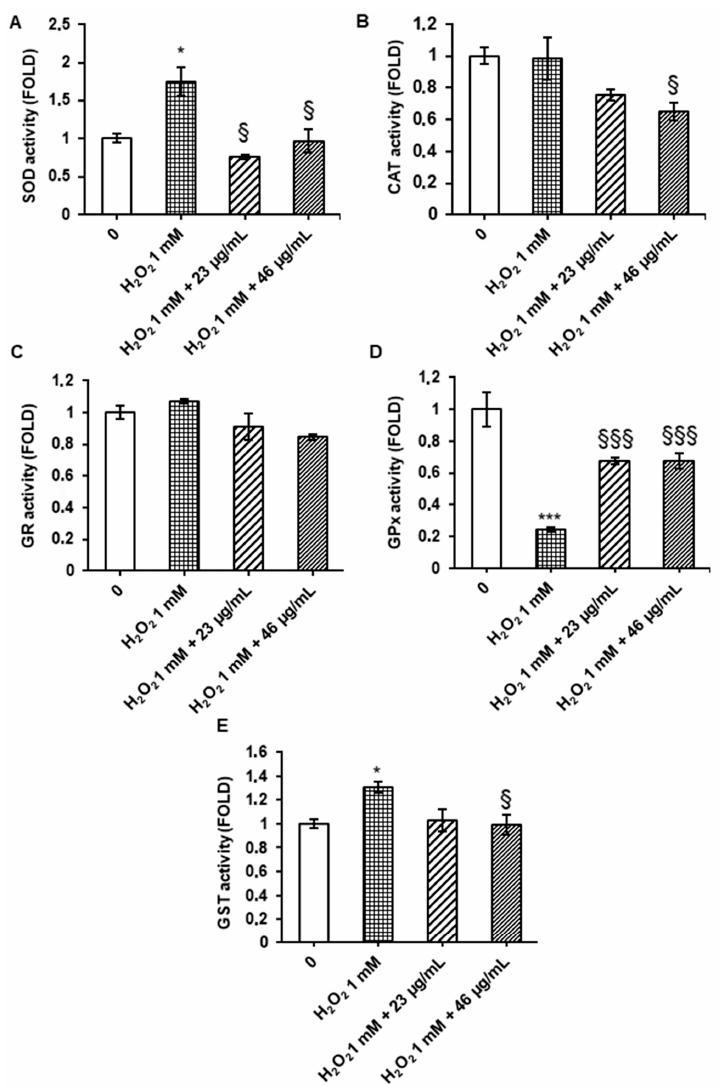
Figure 3. Enzyme activities. Caco-2 cells were treated with digested cinnamon extract at 23 and 46 µ g/mL polyphenols for 24 h, with 1 mM H 2 O 2 for 1 h and with 1 mM H 2 O 2 for 1 h after digested cinnamon extract pretreatment. Results of SOD ( A ), CAT ( B ), GR ( C ), GPx ( D ) and GST ( E ) activities are expressed as folds with respect to untreated control and are shown as mean ± SEM from three independent experiments. Statistical significance: * p < 0.05, *** p < 0.001 respect to untreated cell line; § p < 0.05, §§§ p < 0.001 respect to H 2 O 2 -treated cell